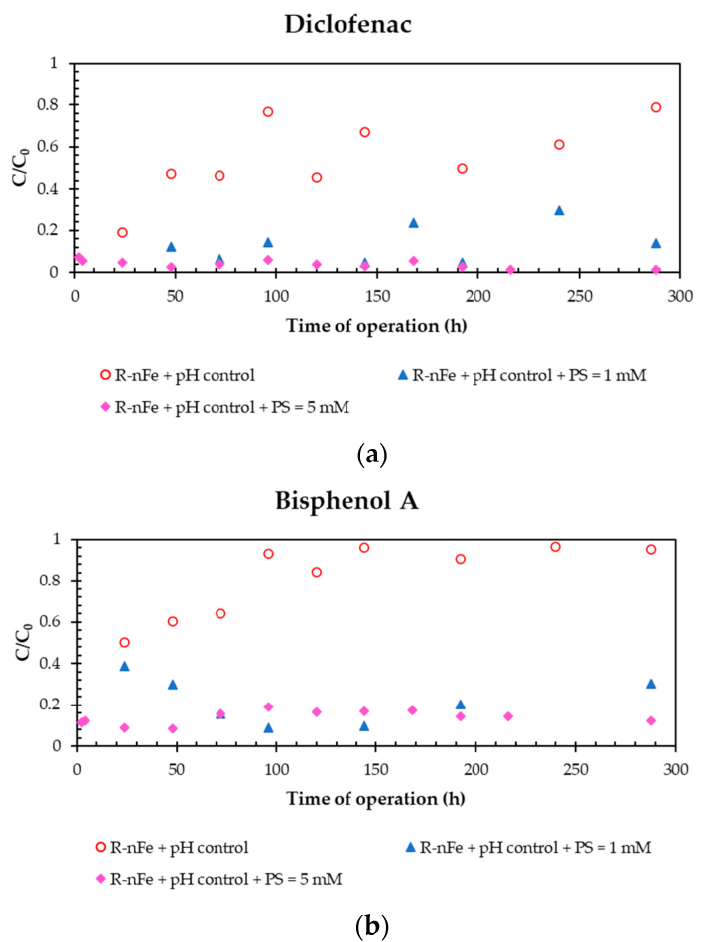
Figure 7. Effect of persulfate dose at controlled pH of the influent matrix to 3.5 on the re- moval efficiency of diclofenac ( a ) and bisphenol A ( b ) (Qwastewater = 26 L/d, Qpersulfate solution = 1.2 L/d, C 0 = 5 µ